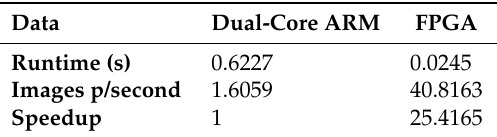
Table 2. DPIM runtime